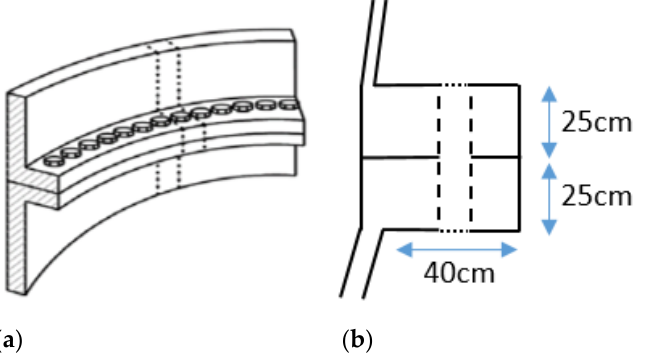
Figure 5. Flange bolted connection: ( a ) Bolted connection, ( b ) Geometric features.